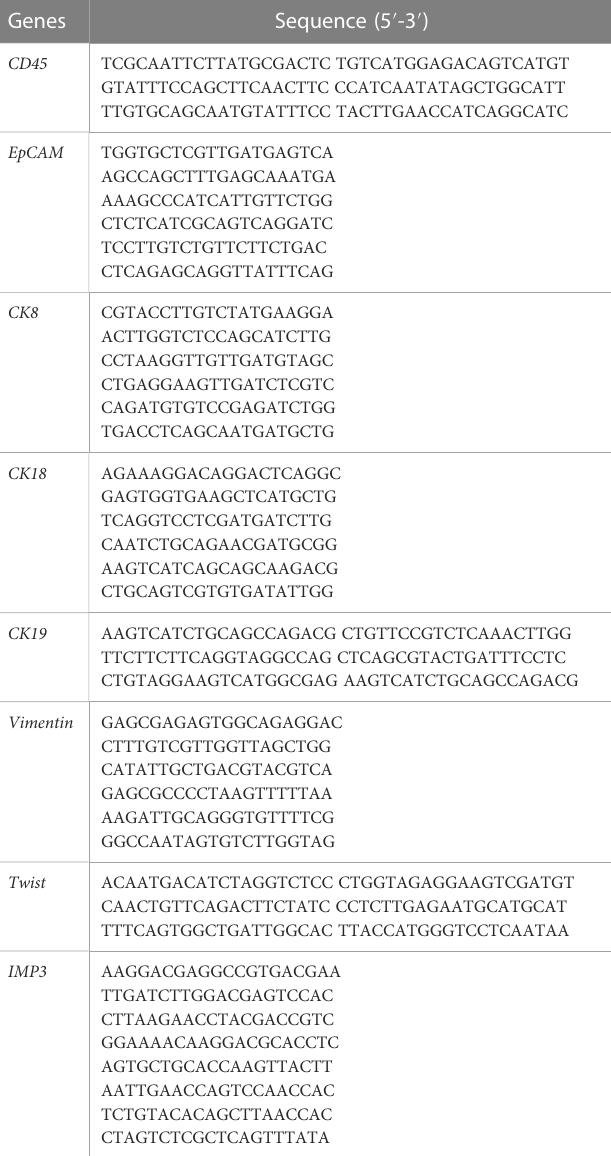
TABLE 1 EMT typing probe and IMP3 probe. Genes Sequence (5 ′ -3 ′